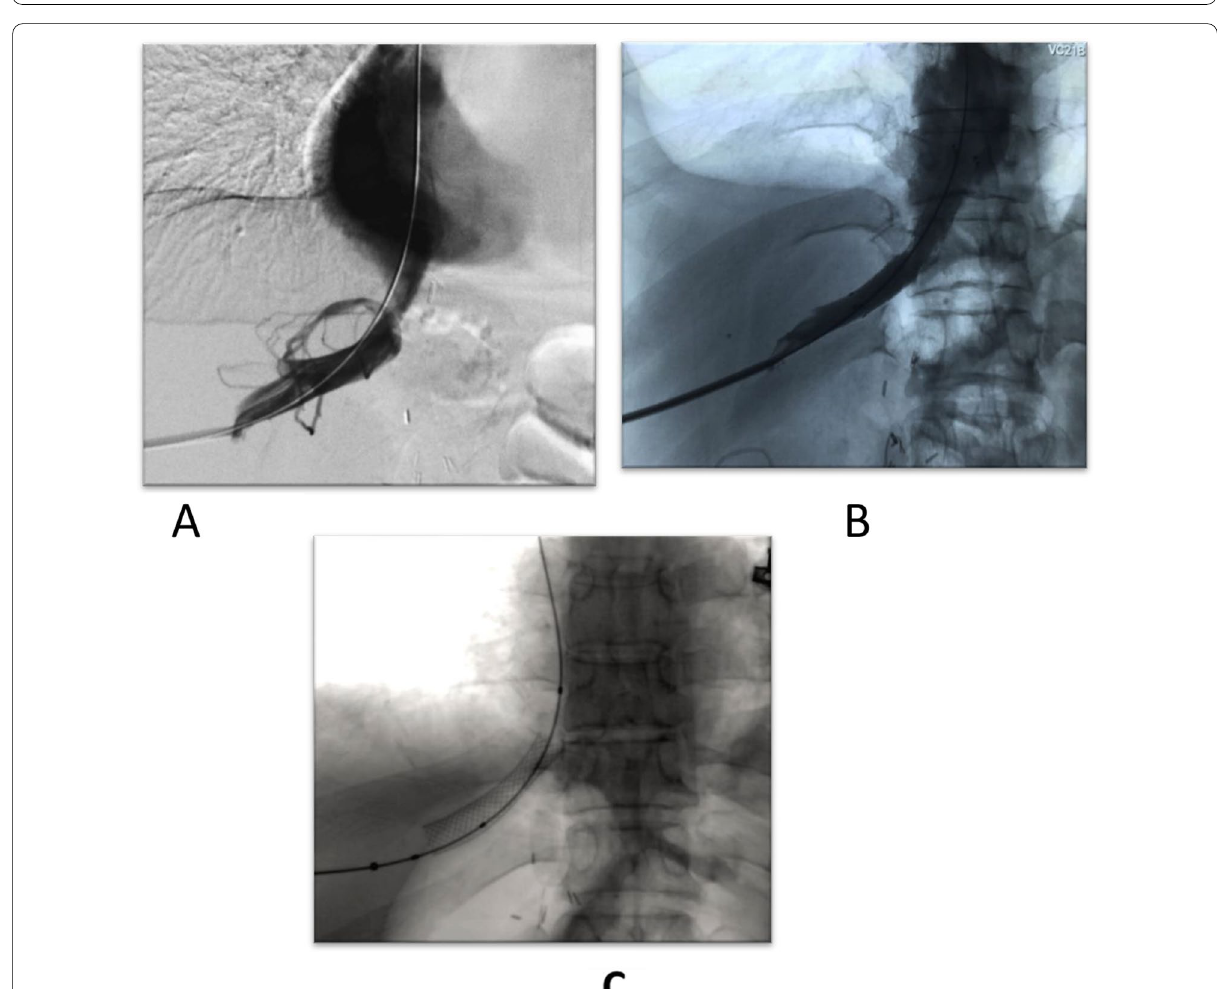
Fig. 14 A Multiple collaterals related to the hepatic vein. B Proper contrast opacification within stent with resolution of collaterals. C A well‑placed stent within hepatic